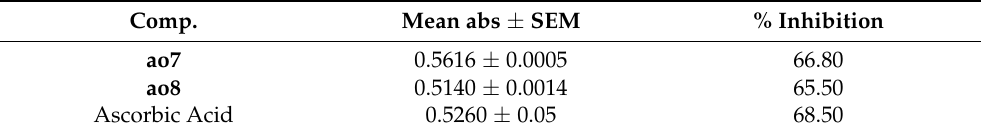
Table 57. Antioxidant screening results of the synthesized compounds ( ao7 – ao8 ) by applying the DPPH scavenging method.